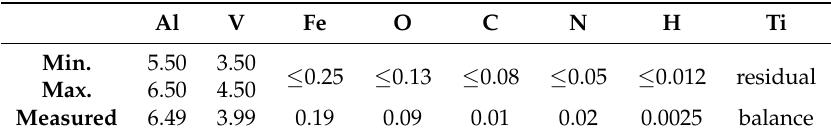
Table 1. Chemical powder composition [17].